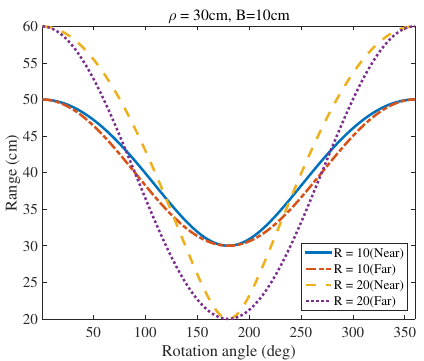
Figure 5. Trajectories of the point targets with close-range ( ρ = 30 cm, B = 10 cm) and far-range ( ρ = 30 cm, B = 10 cm). The difference between the close-range and far-range trajectories increased in regions that were far from the center of